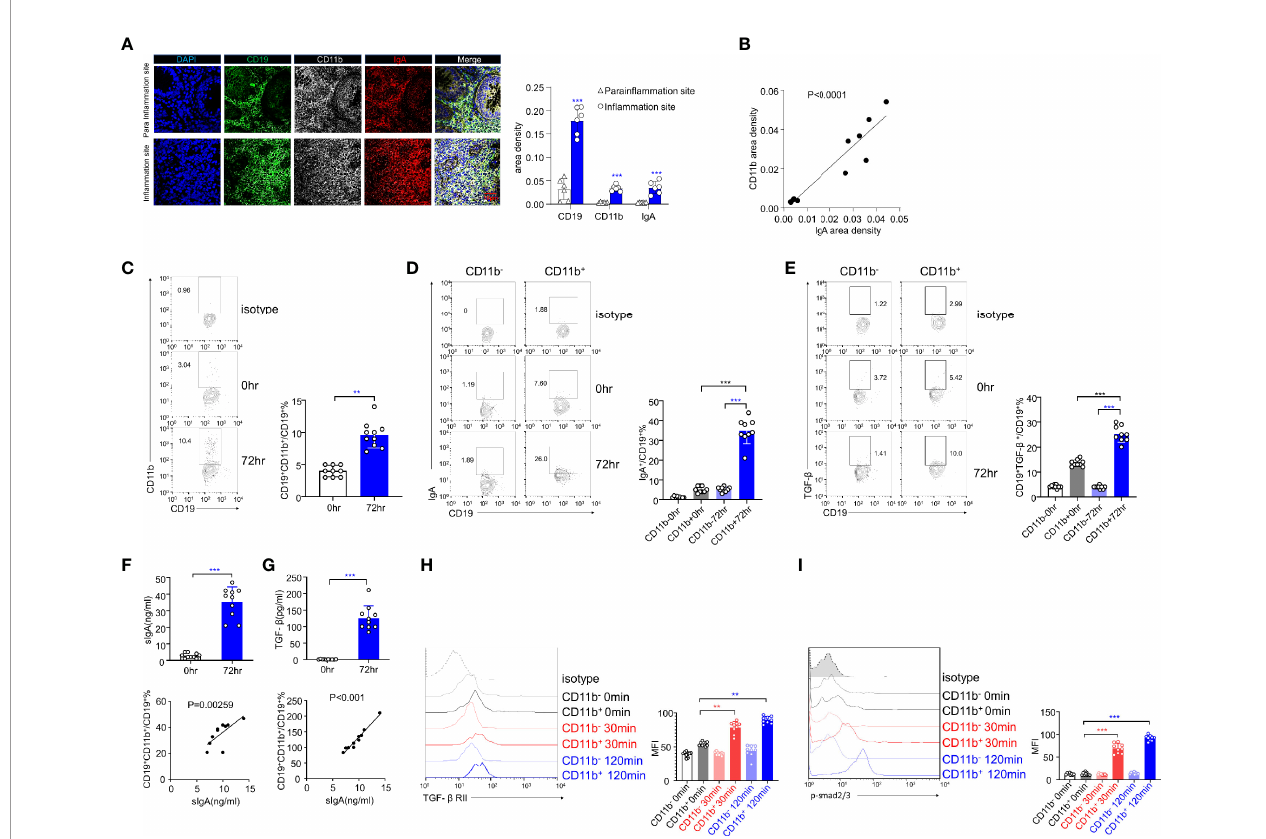
FIGURE 6 | The expression levels of IgA and TGF- b /Smad pathway are upregulated in human CD11b + B cells in vitro . (A) Representative staining of CD19 (green), CD11b (white), IgA (red), and 4 ′ , 6-diamidino-2-phenylindole (DAPI) (blue) in the colon tissue of ulcerative colitis (UC) patients. The area density of each marker was calculated. Average data were collected from 20 random fi elds per patient, n = 6. (B) The relative area density of CD11b and IgA was identi fi ed. (C) Total PBMCs were puri fi ed and stimulated with CpG-ODN (2 m g/mL) and recombinant human IL-10 for 72 h in vitro . Cells were stained for CD11b detection and analyzed using fl ow cytometry. (D) The percentage of IgA + B cells in CD11b + and CD11b − B cells was analyzed using fl ow cytometry. (E) The percentage of TGF- b + B cells in CD11b + and CD11b − B cells was analyzed using fl ow cytometry. (F) The culture supernatant was harvested to determine the production of IgA (upper panel) via ELISA. The relative frequencies of CD19 + CD11b + cells and sIgA level were measured (lower panel). (G) The culture supernatant was harvested to determine the production of TGF- b (upper panel) via ELISA. The relative frequencies of CD19 + CD11b + cells and TGF- b level were measured (lower panel). The PBMCs from healthy donors were puri fi ed and subsequently stimulated by CpG and TGF- b for 0, 30, and 120 min. Expression of TGF- b RII (H) and the phosphorylation level of Smad2/3 (I) were analyzed using fl ow cytometry. **P < 0.01; ***P < 0.001. Data represent the mean of more than three independent